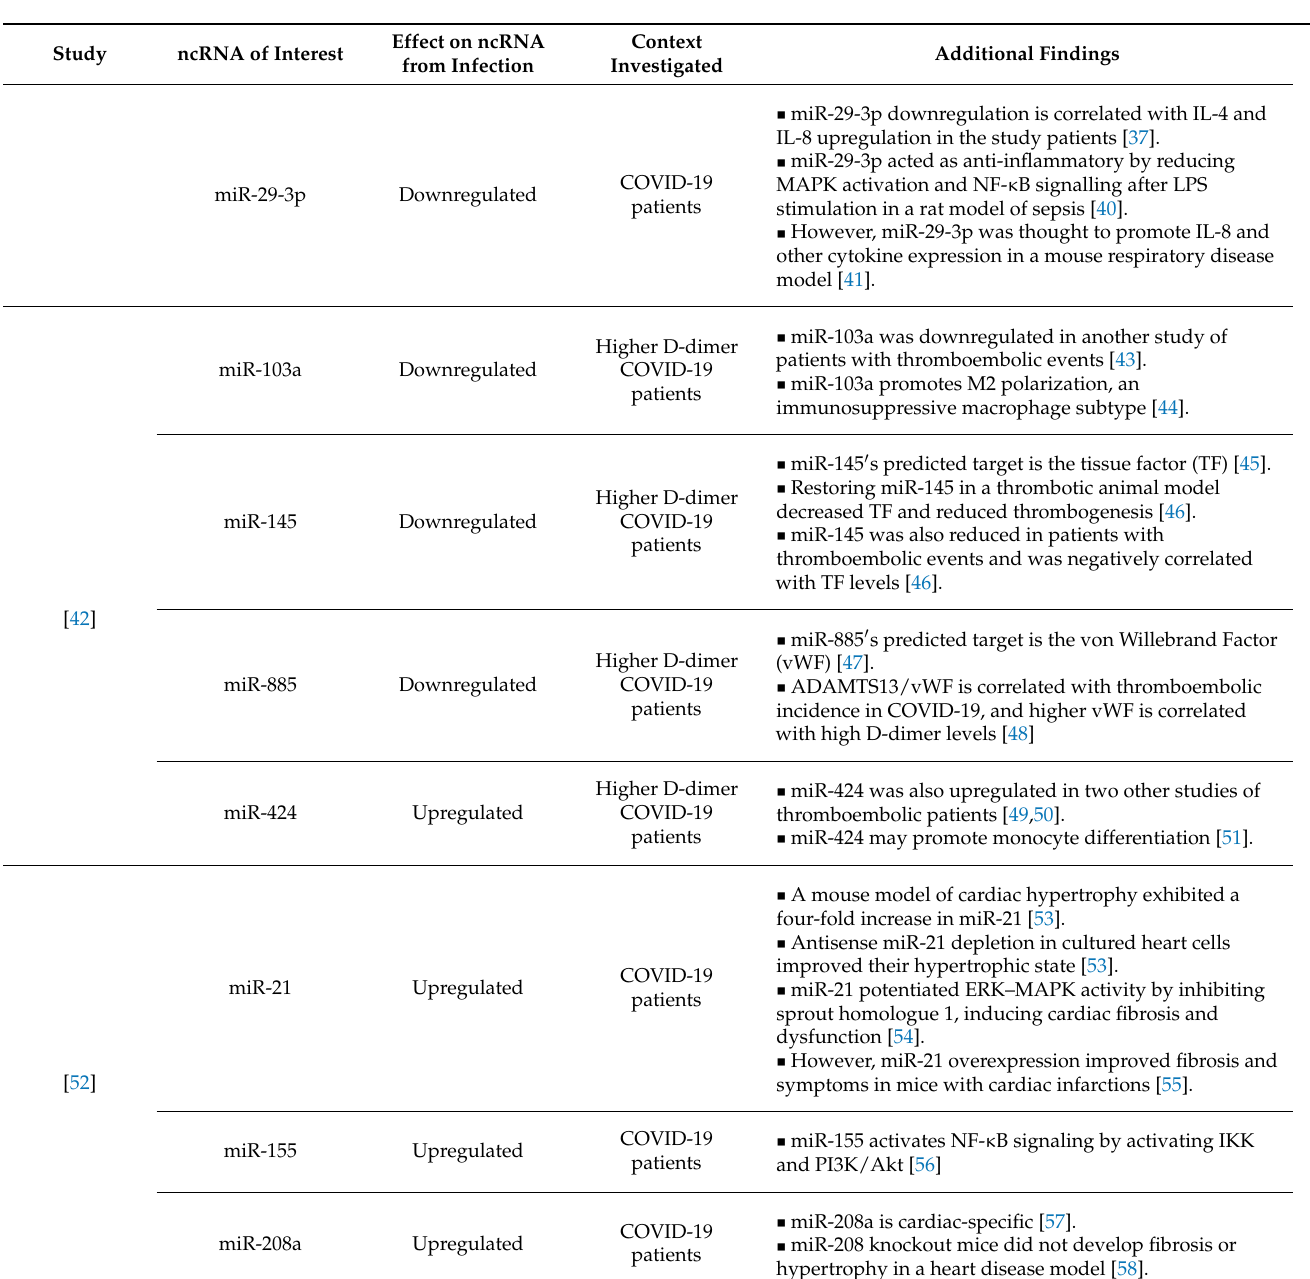
Table 1. A summary of the published COVID-19 ncRNA profiling studies with relevant literature highlighted.